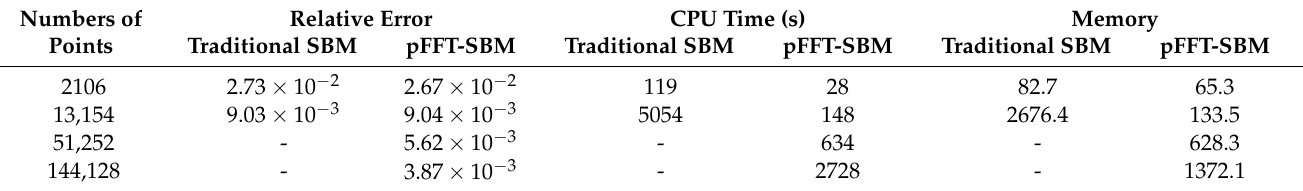
Table 2. The results of a low-frequency case of example 2 by the traditional SBM and